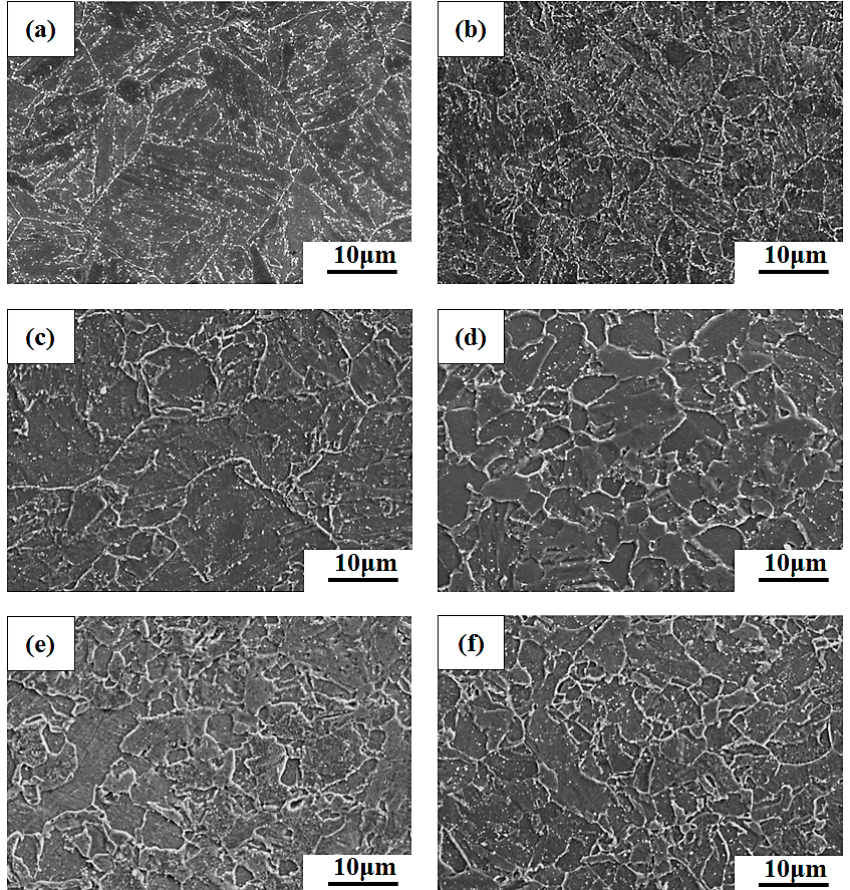
Figure 2. Scanning electron microscope (SEM) micrographs of the ( a ) 1060NT, ( b ) 940NT, ( c ) 1060NT-OT, ( d ) 940NT-OT, ( e ) 1060NT-PT, and ( f ) 940NT-PT samples.